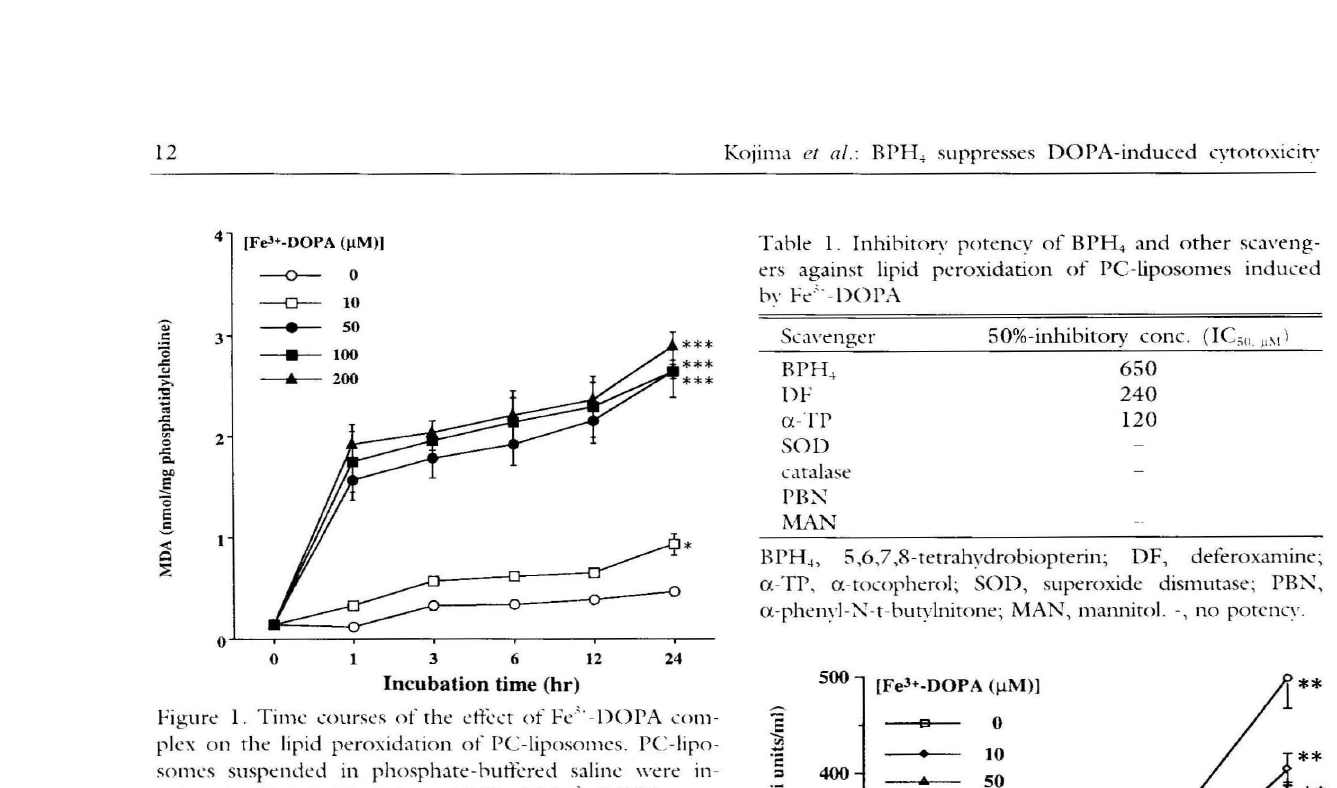
figure I. Time courses of the ett~ct of fe"'-1)OPA COI1l plex on the lipid peroxidation of PC-liposol1les. PC-Iipo somes suspended in phosph:ue-hutfered saline were in cuhated with 10, 50,100, and 200 pM fe 3 --DOPA com plex for 24 hr. Aliquots of sample were collected at in tervals and suhjeered to lipid peroxide assaI'. Lipid perox ides are represented as the content of malondialdehyde (MDA ). Each value is the mean ± S.E.M. of 3 indepen dent assaI's. SignifiC:lI1t11' ditt~rent f,'om the nnrmal con trol (0 pM): *P<0.05, ***1'<0.001.